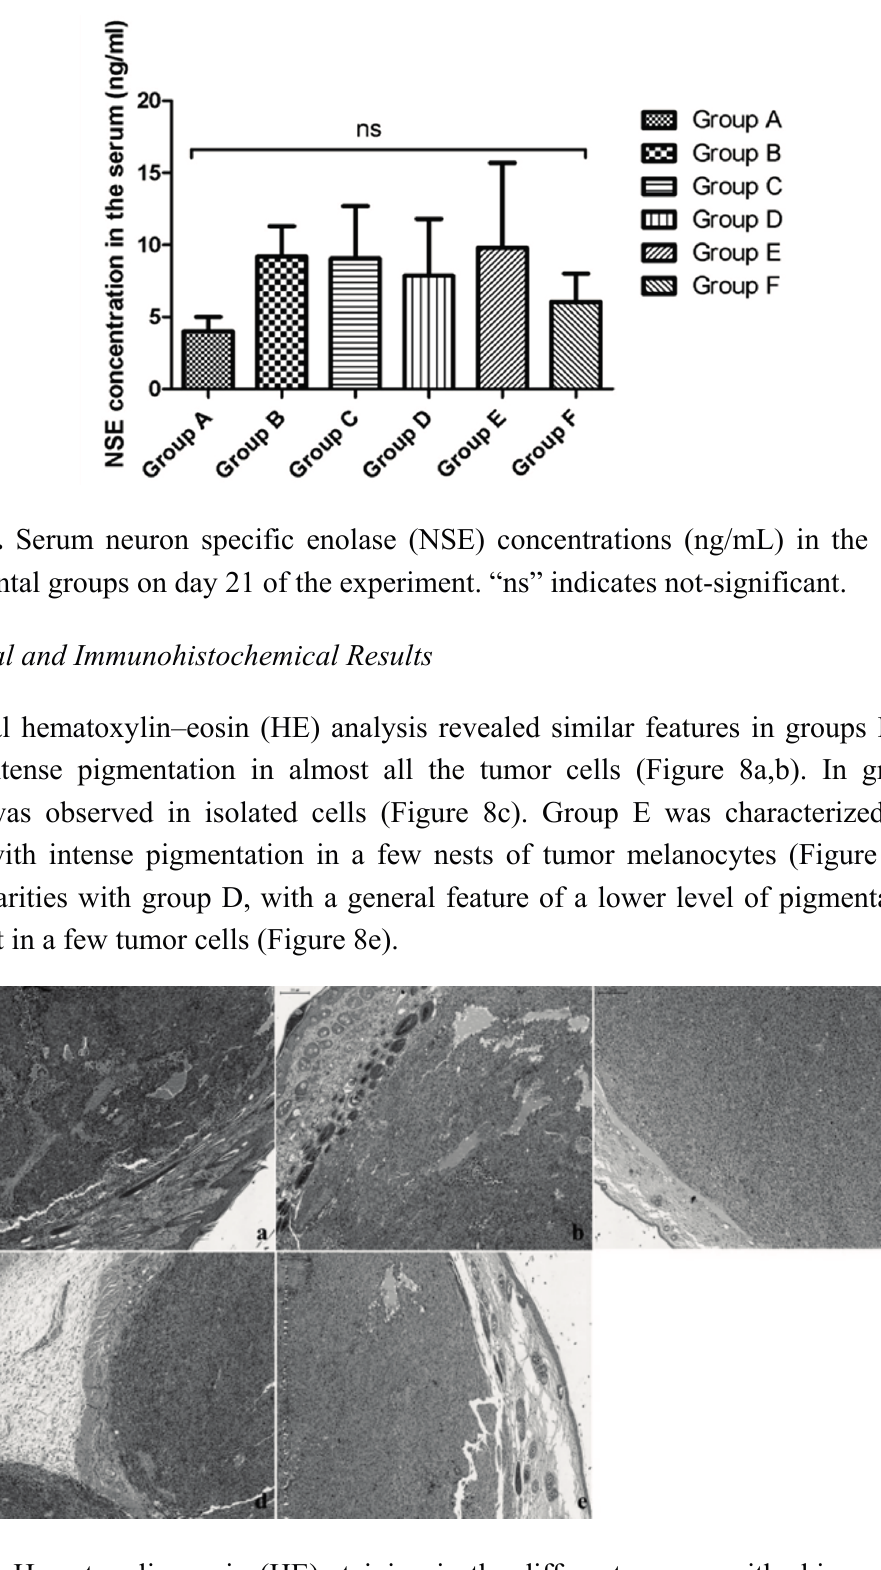
( a , b ): groups B and C with moderate to intense pigmentation in almost all the tumor cells; ( c ): group D, exhibiting melanoma with weak and isolated pigment; ( d ): group E, displaying moderate pigmentation, with intense pigmentation in a few nests of tumor melanocytes; ( e ): group F, with the presence of melanin in isolated cells. Magnification: 40×; scale bar: 200 μ